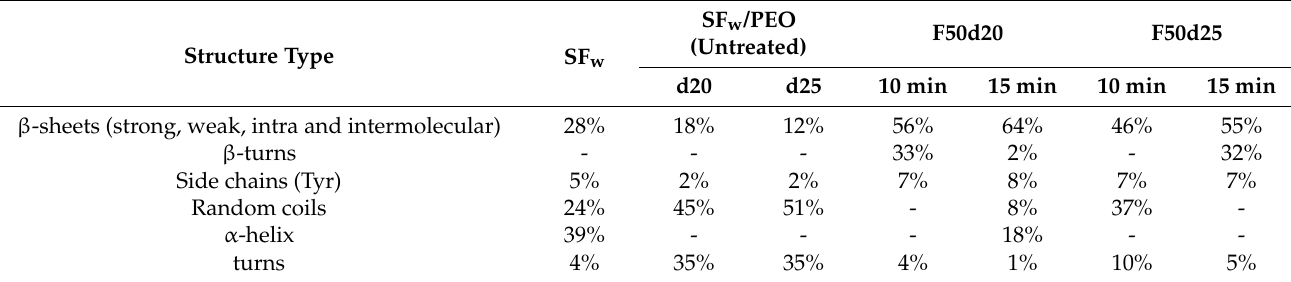
Table 2. Secondary structures present in the vibrational mode of amide I for treated and untreated electrospun membranes with methanol for 10 min and 15 min. SF w films were used as control.